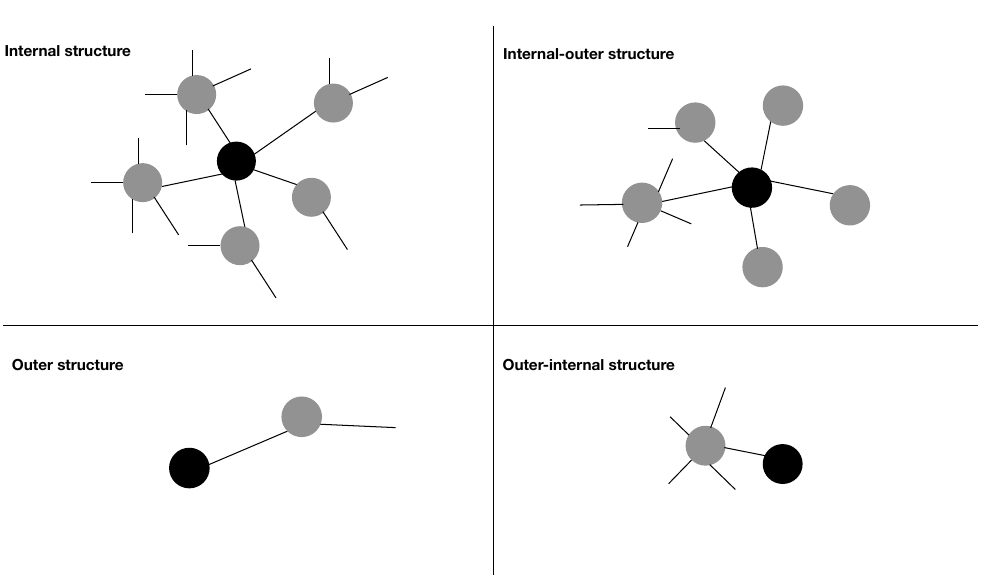
Figure 1. Four kinds of local status. Combinations of the self-distribution and the neighbor- distribution can depict the different local status. The nodes with the Internal structure have the high values of two distributions; the nodes with the Internal-outer structure have the high value of the self-distribution and the medium value of the neighbor-distribution; the nodes with the Outer structure have the low values of both two distributions; the nodes with the Outer-internal structure have the low value of the self-distribution and the medium value of the